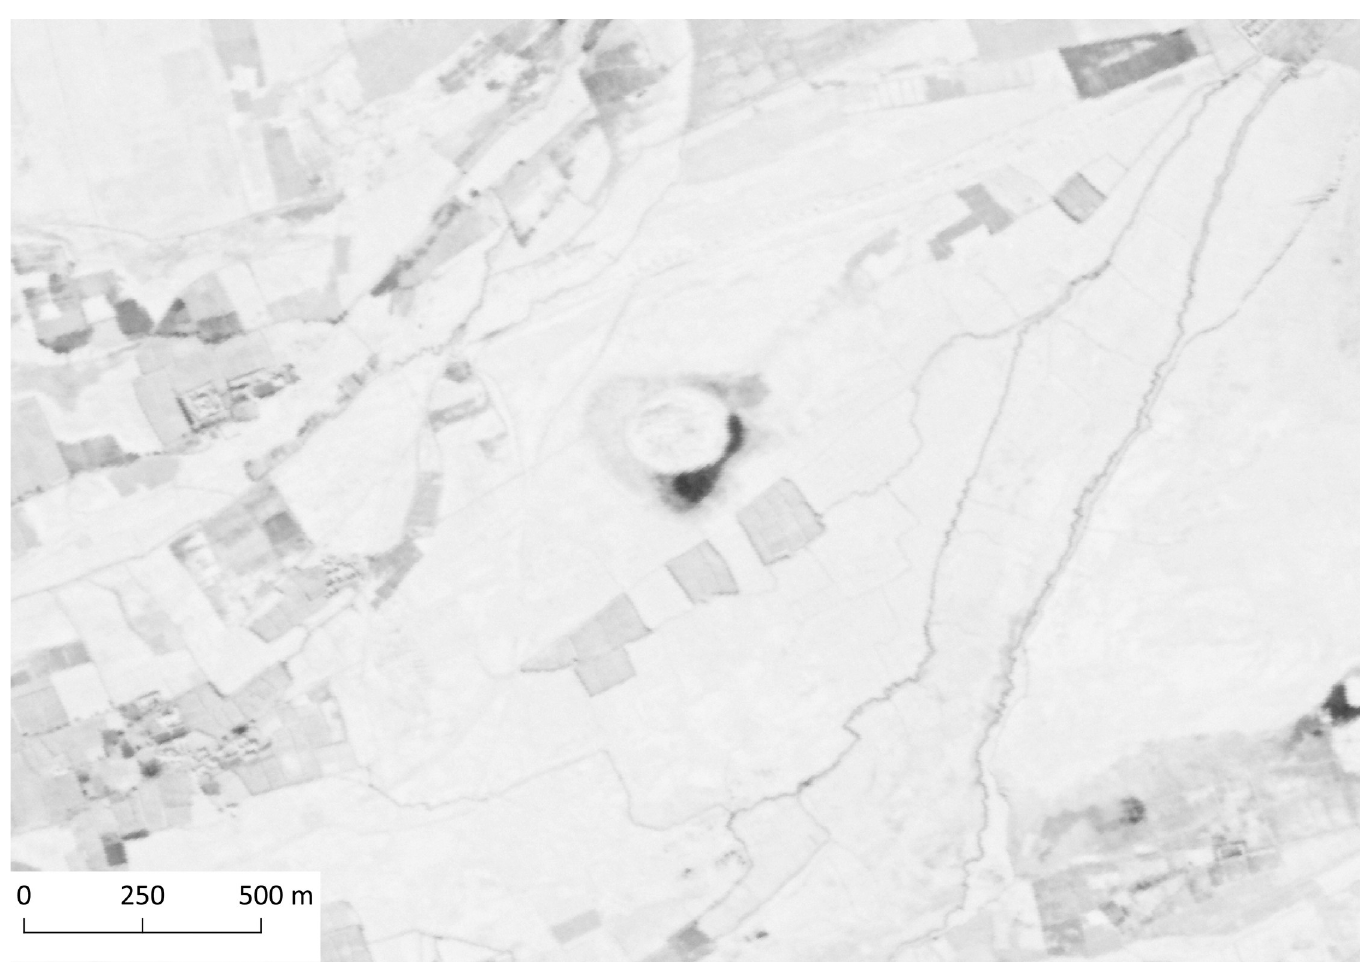
Fig 6. Said Qala Tepe. CORONA Satellite image courtesy of the U.S. Geological Survey (DS1108-2234DA032_a, 19.12.1969) (https://earthexplorer.usgs.gov).